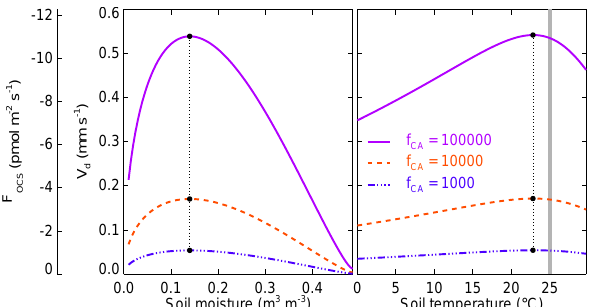
Figure 6. Sensitivity of the modelled OCS flux ( F OCS ) and depo- sition velocity ( V d ) to soil CA activity. The soil moisture and tem- perature response curves shown here were obtained using the diffu- sivity model of Moldrup et al. (2003) and assuming no source term, a soil pH of 7.2 and a soil depth of 1m. Closed circles indicate the temperature or soil moisture optimum of each response curve and the grey thick line in the right panel indicates the set optimal tem- perature for CA activity (25 ◦ C in this case).